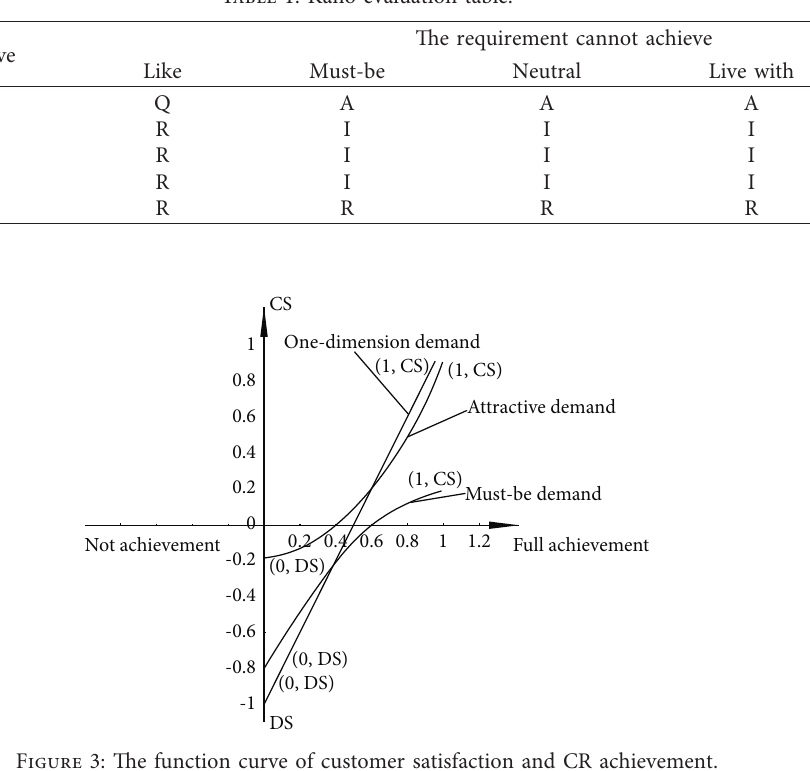
Table 1: Kano evaluation table.